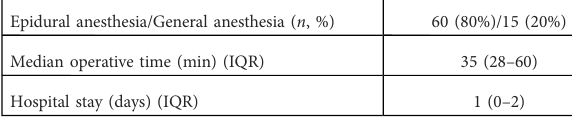
TABLE 2 Procedural results (T0), number (percentage). IQR, interquartile